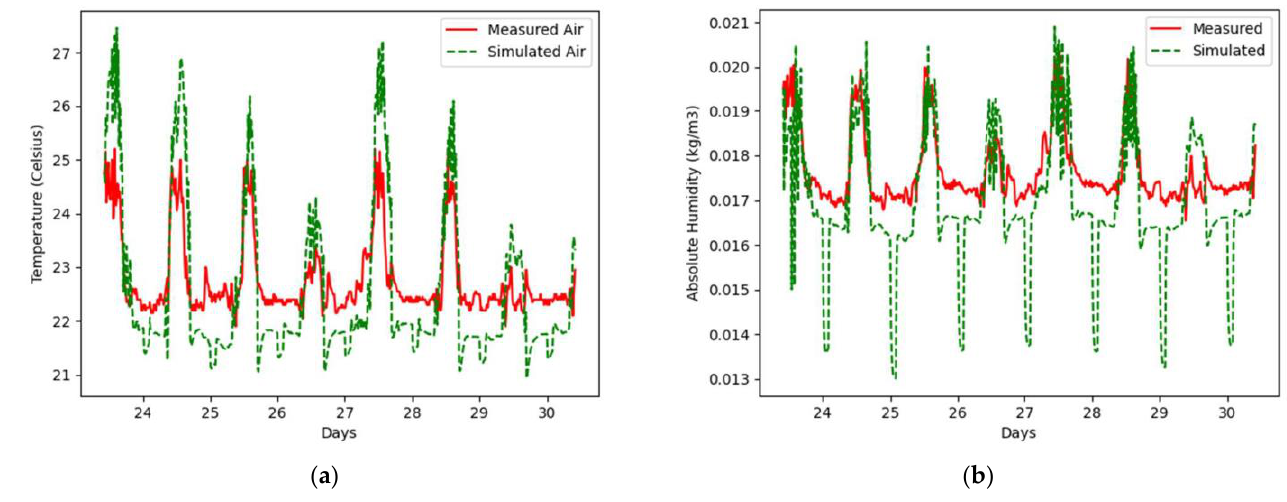
Figure 4. Simulated versus measured values with MRD running: ( a ) air temperature—MRD running, Table 6. Results of validation test cases. Percent difference shown in parentheses.